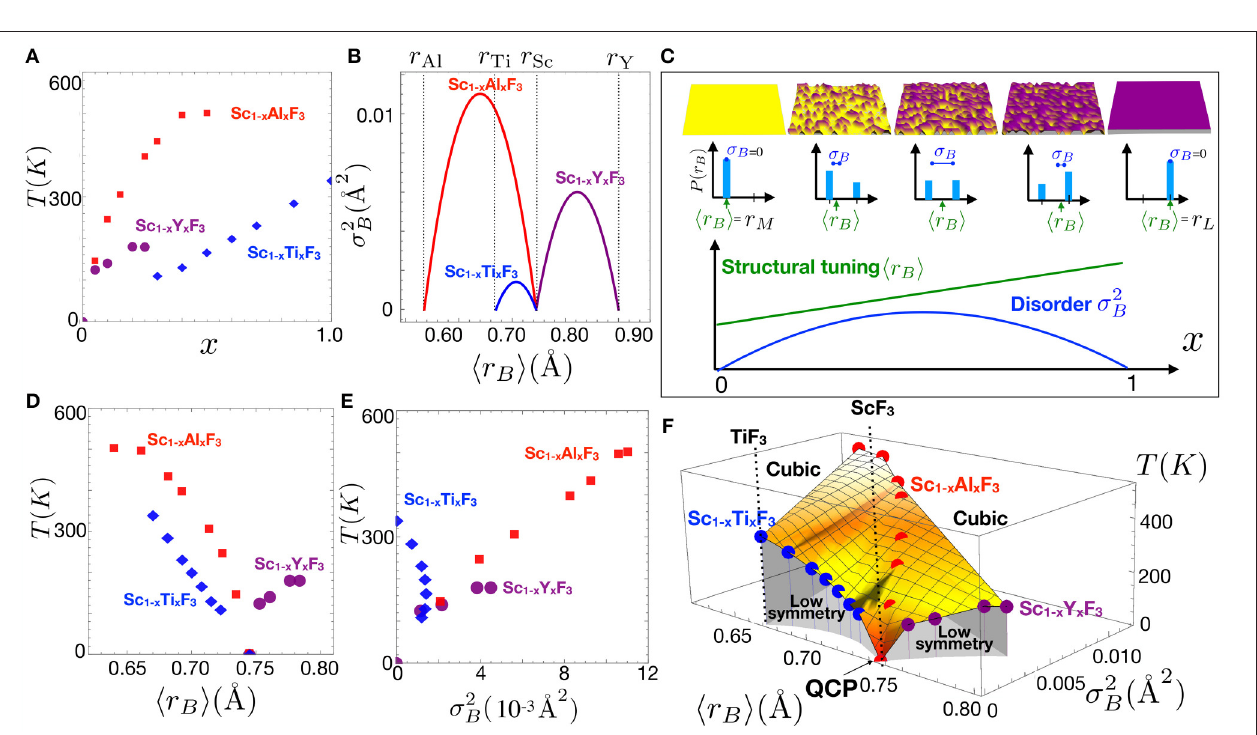
FIGURE 9 | (A) Cubic-to-rhombohedral transition temperatures T c (x) in a isovalent substitutional series Sc 1 − x L x F 3 . (B) The dependence of the mean and variance using Equation (8) and the Shannon ionic radii of the Ti, Y, and Al. ( C , top row) Illustration of the effect of substitution on the potential energy landscape in a solid solution as the composition x is varied. ( C , middle row) The binary probability distributions P ( r B ) for the five composition levels with the mean and standard deviation σ B of the distributions indicated by arrows and dumbbells, respectively. ( C , bottom) plot of the composition dependence of the first two moments of the distribution according to Equation (8). Plot showing the dependence of the transition temperatures as a function of (D) h r B i and (E) σ 2 B , respectively, which show no obvious universal trend. (F) Combined plot of the transition temperatures vs. the structural tuning parameter h r B i and the disorder parameter σ 2 B .